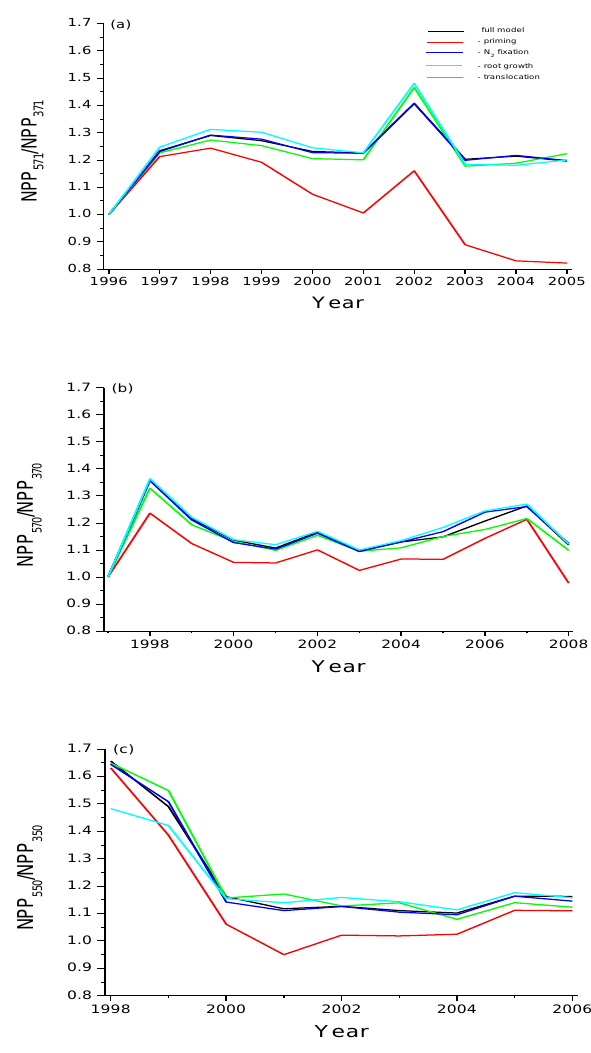
Fig. 13 Fig. 13. Ratios of annual net primary productivity (NPP) modelled under ambient vs. elevated C a at the (a) Duke, (b) ORNL and (c) Rhinelander FACE experiments with the full model or with model algorithms for priming by litterfall [A3], nonsymbiotic N 2 fixation [A27], increased root growth driven by plant C status [C50], and translocation driven by plant N status [C19] disabled (–). Agree- ment between enabled and disabled algorithms for NPP modelled under ambient C a at each site was achieved by offsetting changes in model parameters affected by disabling as described in the Meth-